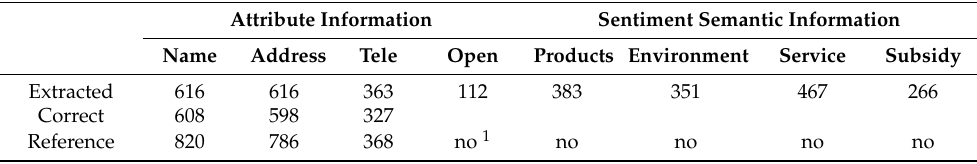
Table 4. Evaluation of attribute and semantic information of the gas station.